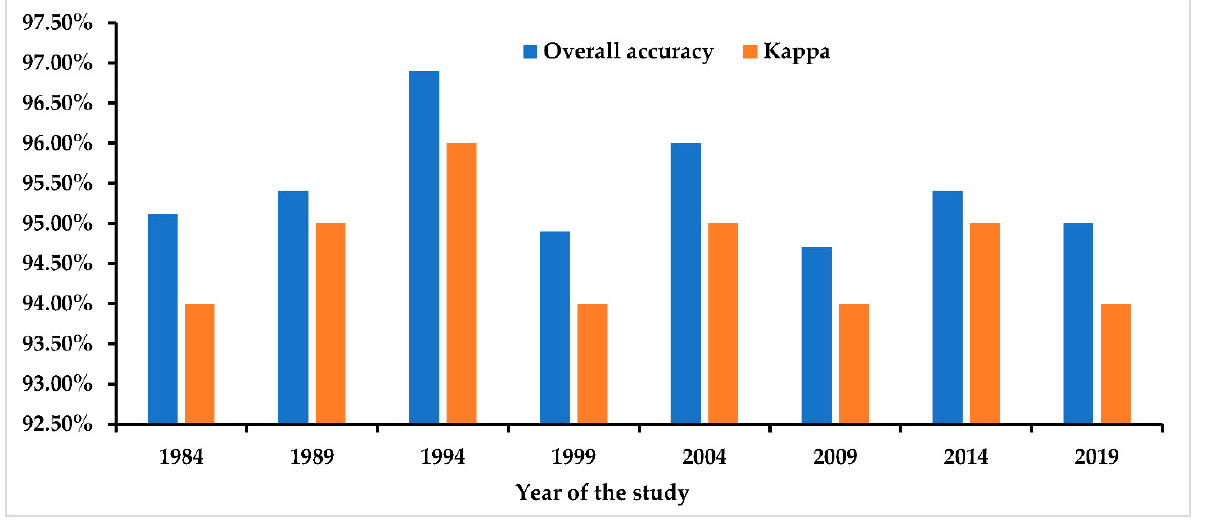
Figure 4. The overall accuracy and kappa coefficient achieved by random forest classifier for map- ping rainfed agriculture and other LULC classes for the period between 1984 and 2019 with a five-year interval. Table 3. User and producer accuracies for mapping rainfed agriculture and other LULC classes for the period between 1984 and 2019 in five-year intervals. The accuracies were calculated using the test dataset (30%) and the confusion matrix.